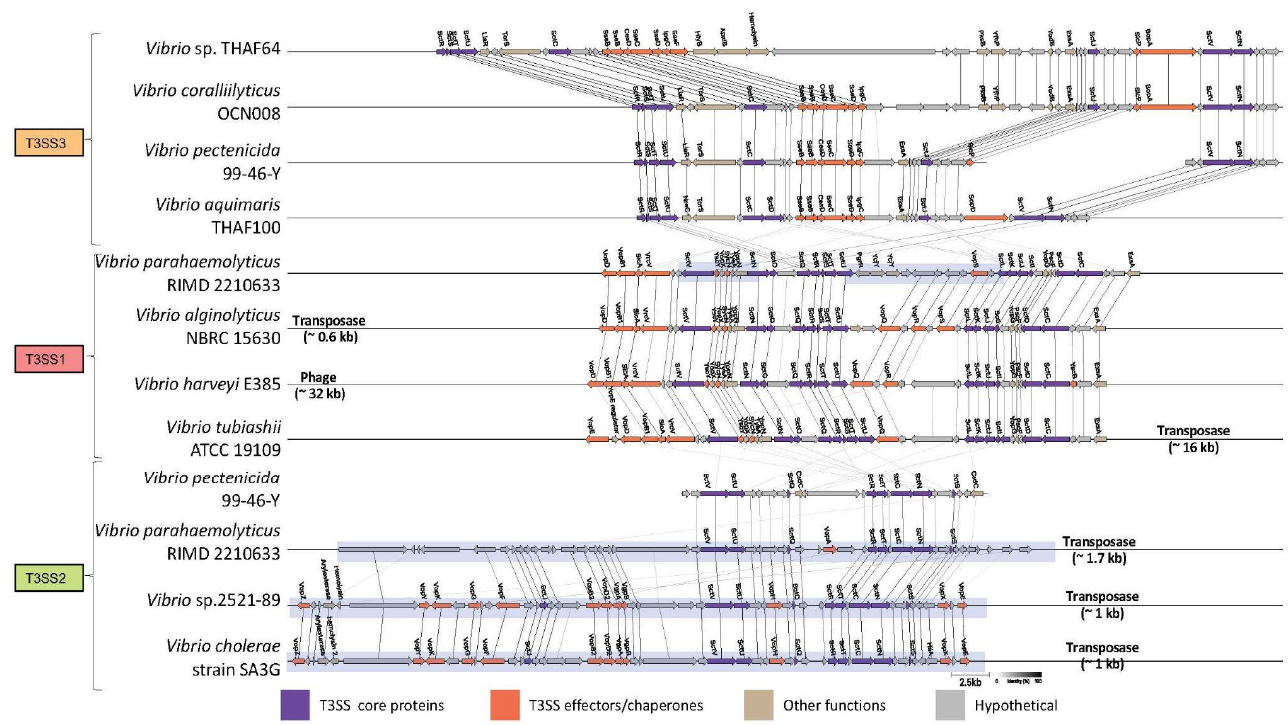
Figure 3. Gene orders of the T3SS1/2/3 clusters. Arrow direction and color correspond to respective coding strand and gene function, respectively. Arrow size reflects amino acid length, and the lines between arrows represent orthologs as computed by the Clinker software (see Methods). Genomic island is visualized as a blue shade. Genomic positions are shown in Supplementary Table S3.